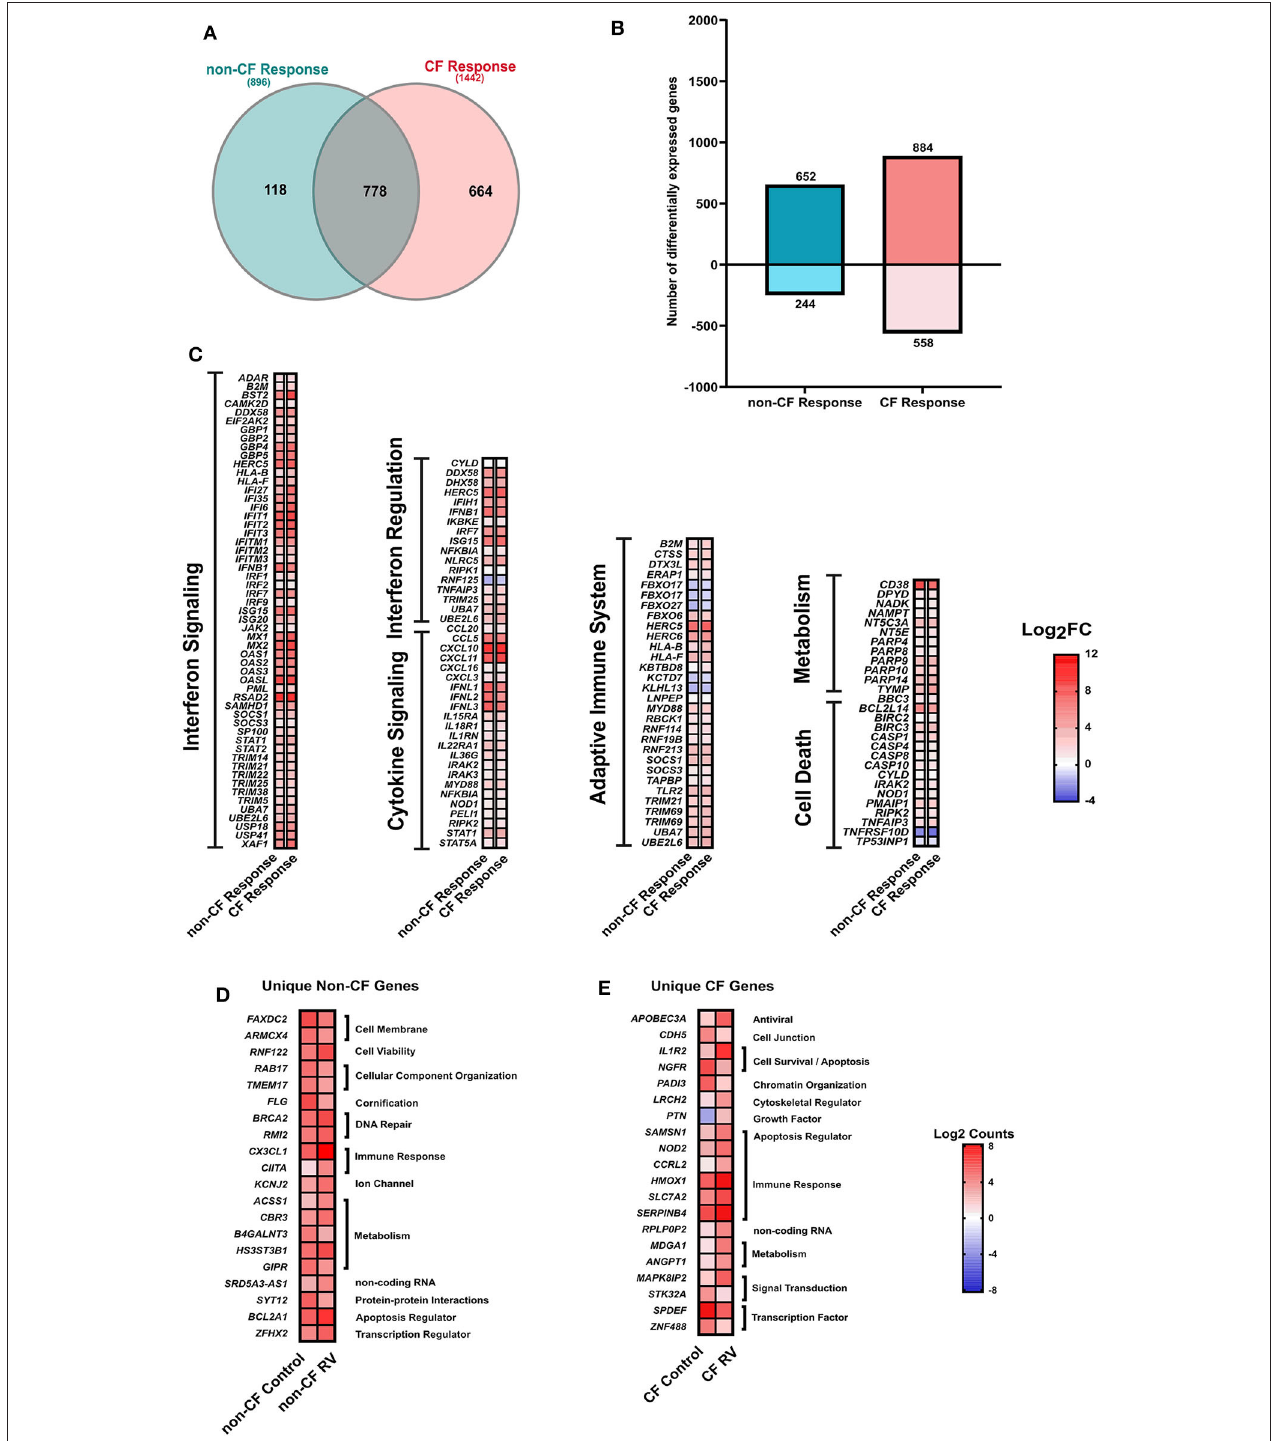
FIGURE 3 | Response to rhinovirus infection. (A) Venn diagram comparing the differentially expressed (DEGs) genes between non-CF (teal; non-CF RV-infected vs. non-CF non-infected control ) and CF (pink; CF RV-infected vs. CF non-infected control ) response to RV1B infection. A total of 778 DEGs were common between non-CF and CF response to RV1B infection. (B) The number ( y -axis) and direction of change (upregulated DEGs (|Log 2 FC|1.5, adjusted p -value < 0.05) of non-CF and CF response to rhinovirus infection ( x -axis). (C) The relative expression genes that are commonly differentially expressed (|Log 2 FC| > 1.5, adjusted p -value < 0.05) in airway epithelial cells (AECs) from non-CF and CF individuals when infected with rhinovirus. These